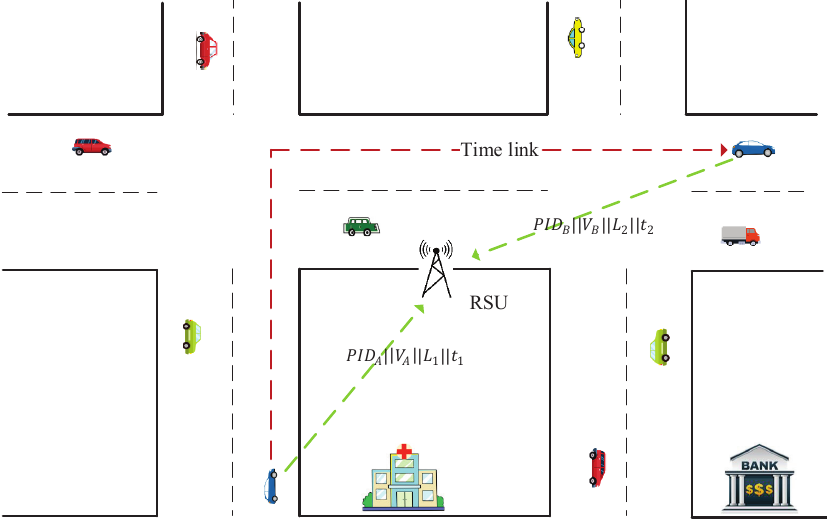
Figure 1. Using passing time to link